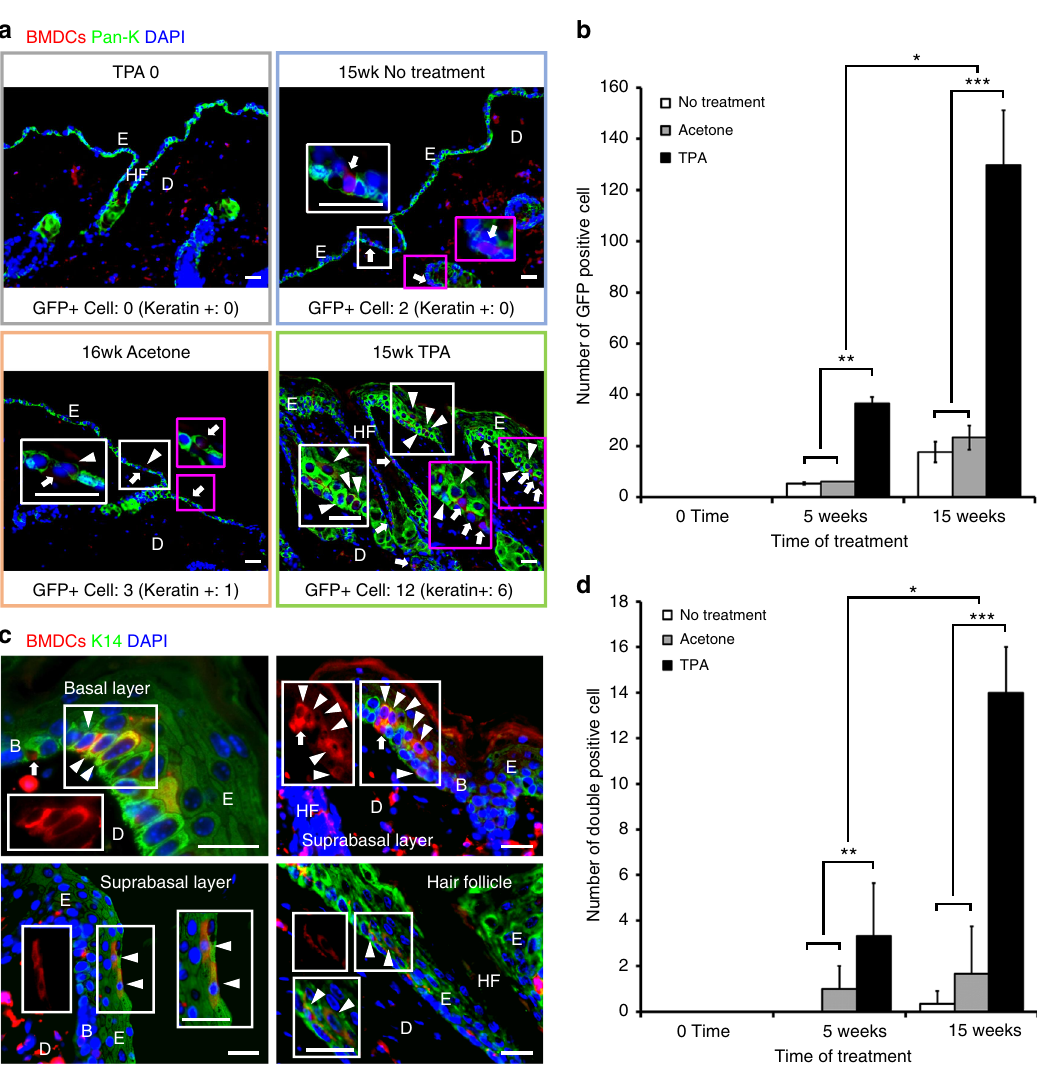
Fig. 2 Long-term TPA treatment increases BMDCs in the epidermis of the skin. a BMDCs were detected in the epidermis of the skin with different treatment groups (before TPA treatment, no treatment, acetone-treated, and TPA-treated) and speci fi c areas in white and magenta boxes are magni fi ed. Arrows indicate keratin-negative BMDCs and arrowheads indicate keratin-positive BMDCs. b The number of GFP-positive cells in the epidermis are compared among three different treatment groups (no treatment, acetone-, and TPA-treated) at three different time points. The treatment types (no treatment, acetone, and TPA) are different across all weeks ( P = 5.35 × 10E − 11). The average time effects are different across all treatment levels ( P = 1.32 × 10E − 11). Additionally, the treatment type and time interact in a non-additive fashion ( P = 6.6 × 10E − 10). ( n = 3, over all P value = 5.72 × 10E − 13 as determined by the F -statistic, mean ± s.d.). c Keratin-positive BMDCs were observed in the basal layer, the suprabasal layer, and hair follicle. Areas in white boxes are magni fi ed or shown in single color. Arrows indicate keratin negative BMDCs and arrowheads indicate keratin-positive BMDCs. d The number of GFP/Keratin-positive (double positive) BMDCs in the epidermis are compared among three different treatment groups (no treatment, acetone-, and TPA- treated) at three different time points. The number of double positive cells are increased in long-term TPA-treated groups. Both treatment type (acetone and TPA) and time (in weeks) have signi fi cant effects. This implies that the means of treatment types (no treatment, acetone, and TPA) have different effects across all weeks ( P = 3.87 × 10E − 08). The average time effects are different across all treatment types ( P = 1.95 × 10E − 07). Finally, there is a signi fi cant interaction term; this means that treatment type and time interact in a non-additive fashion ( P = 1.53 × 10E − 07). ( n = 3, overall P value = 1.22 × 10E − 09 as determined by the F -statistic, mean ± s.d.). *Epidermis (E), Dermis (D), Basal layer (B), Hair follicle (HF) **All counted cells